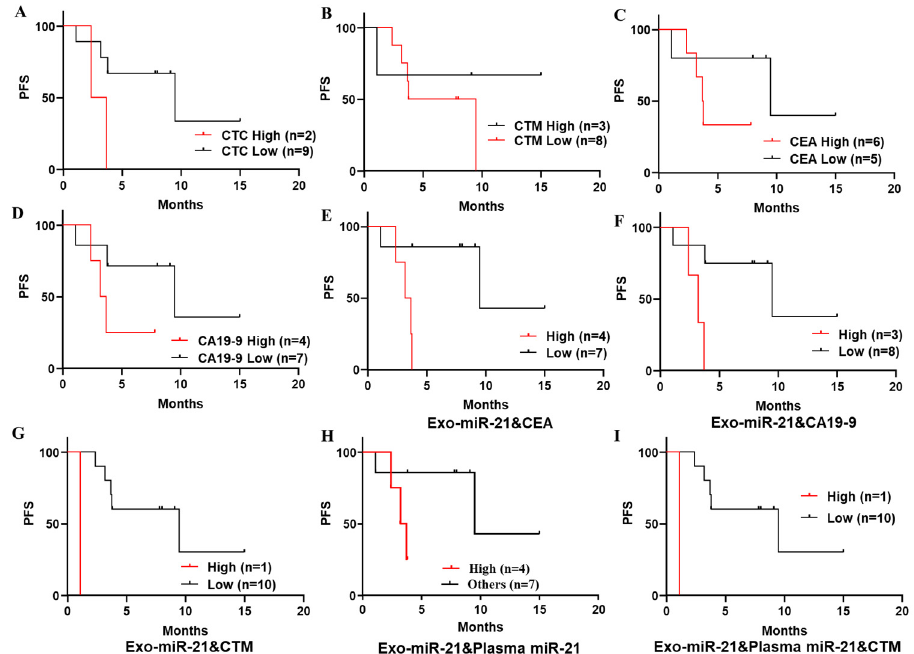
Figure 6. Kaplan–Meier survival analyses on PFS curves to differentiate recurrence in patients with stage IV CRC by individual and combined biomarkers. ( A – D ) PFS curves to differentiate recurrence in patients with stage IV CRC stratified by numbers of CTC ( A ), presence of CTM ( B ), serum CEA ( C ), and CA19-9 levels ( D ). ( E – I ) PFS curves to differentiate recurrence in patients with stage IV CRC stratified by combined biomarkers.